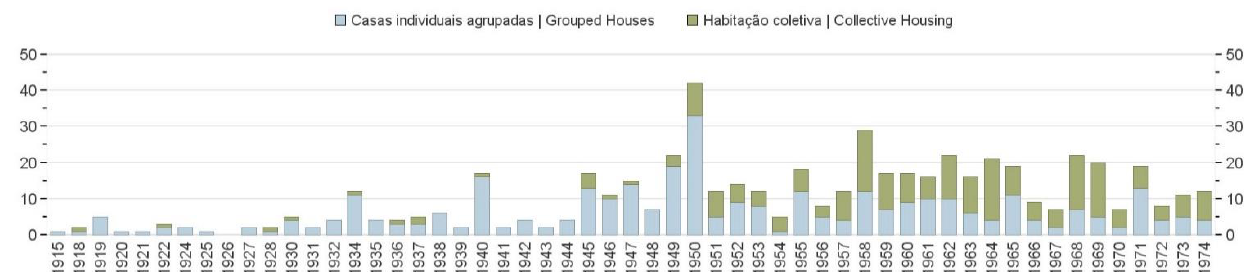
Figure A3. Map of Portugal based on NUTS II, showing the location of neighbourhoods. Source: MdH database, 2019.